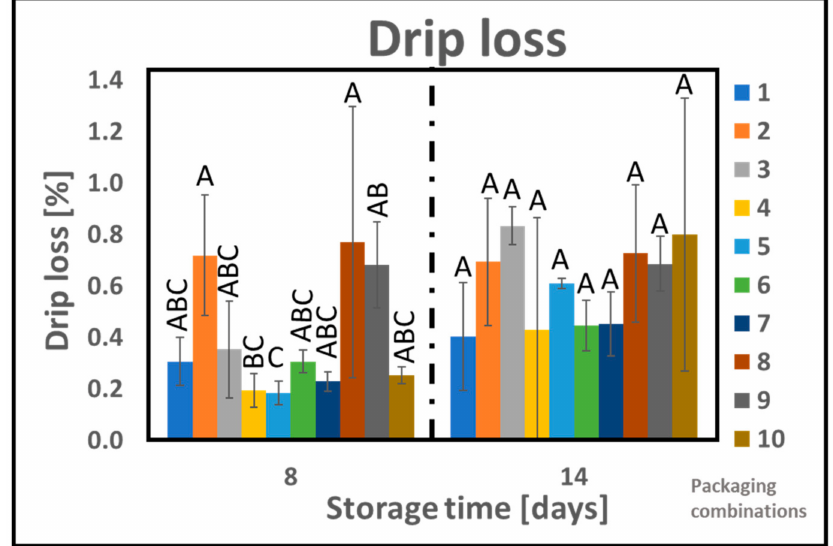
Figure 3. Drip loss of chicken samples as a function of storage time for different packaging combina- tions. One-way analysis of variance Tukey comparison is performed separately at different sampling points. Tukey group is represented by upper case letters, samples which do not share the same letter are significantly